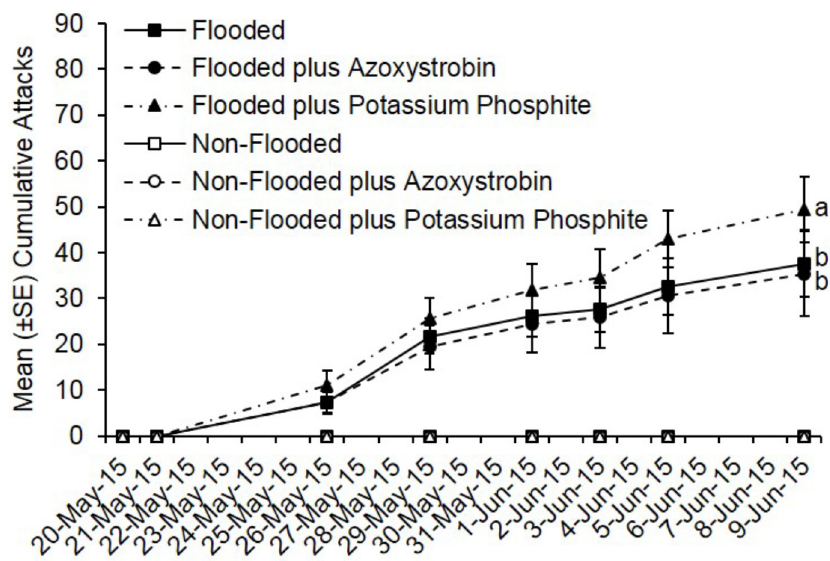
Figure 3. Cumulative ambrosia beetle attacks on C. canadensis trees deployed in Ohio that were either flooded or non-flooded and preventively treated with azoxystrobin, potassium phosphite, or untreated. Trees were flood-stressed, treated with selected fungicides, and deployed on 20-May-2015. Means with different letters on 9-June-2015 are significantly different (flooded vs. azoxystrobin: t = − 0.58; df = 1; p = 0.57; flooded vs. potassium phosphite: t = 2.82; df = 1; p = 0.005). Only the flooded trees were included as part of the analysis because no attacks occurred on any of the non-flooded trees.